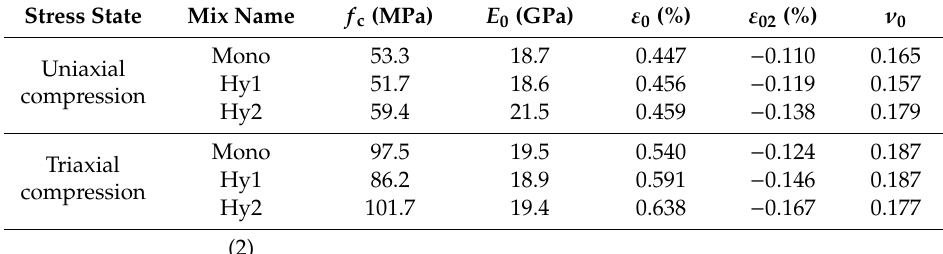
Table 3. Mechanical parameters of ECC mixtures with different steel fiber content under uniaxial and triaxial compression.